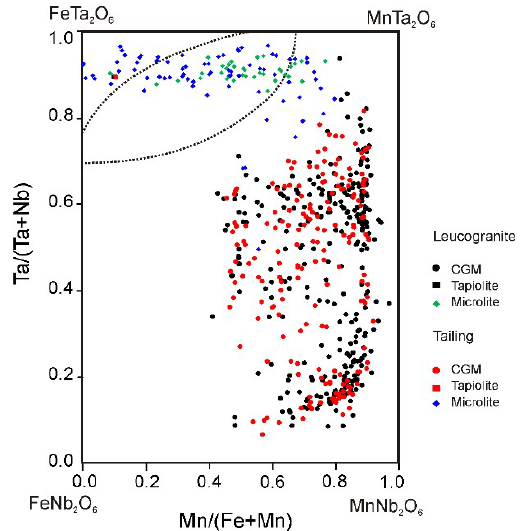
Figure 9. Chemical composition of columbite-group minerals (CGM) and microlite from the Penouta leucogranite outcropping ore [45] and from tailings in the columbite quadrilateral.